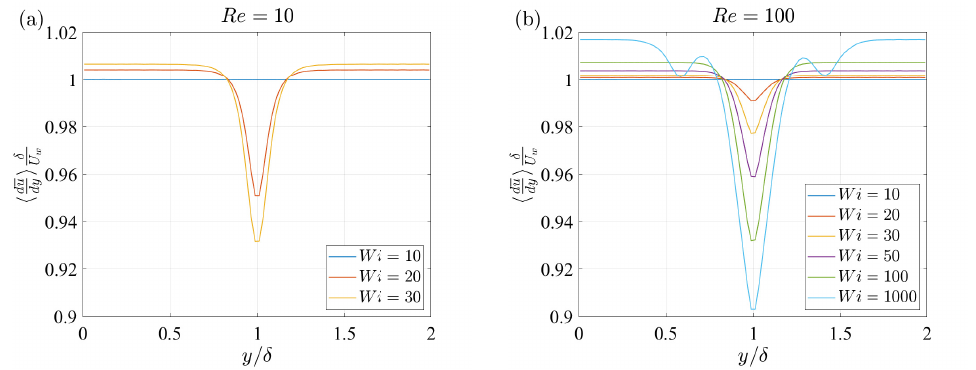
Figure 4. Mean velocity profiles for increasing Wi , with ( a ) Re = 10 and ( b ) Re = 100, with the insert magnified around the channel center.